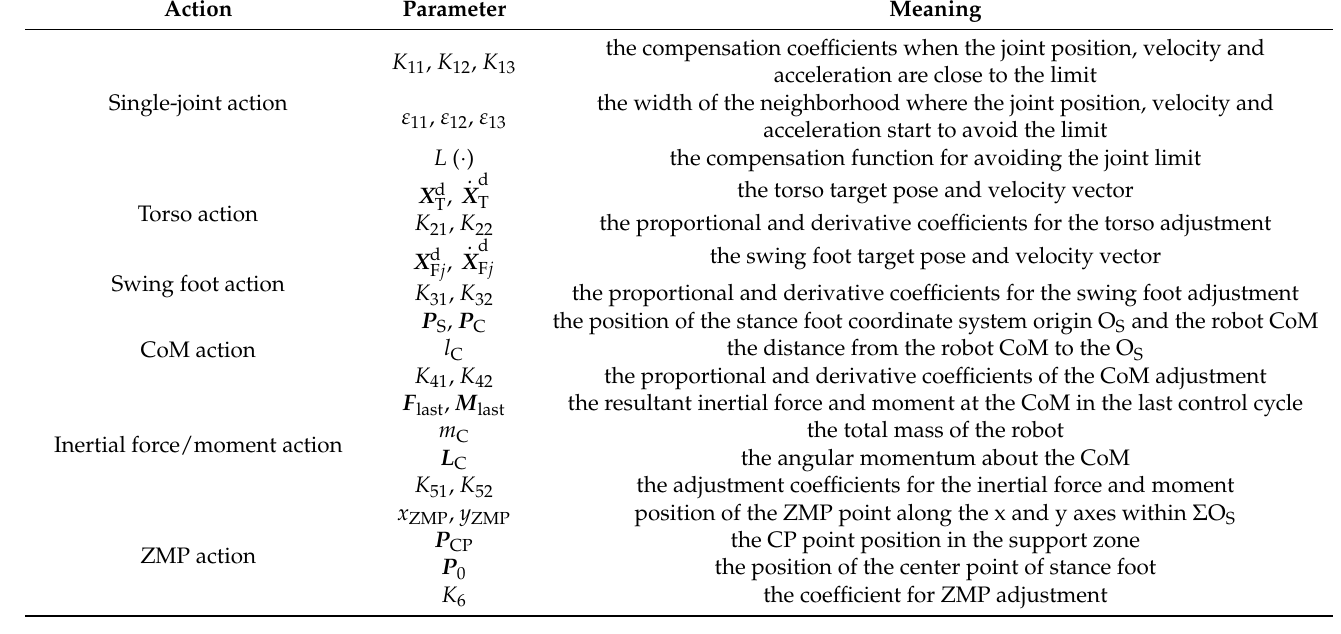
Table 3. Parameter table for action